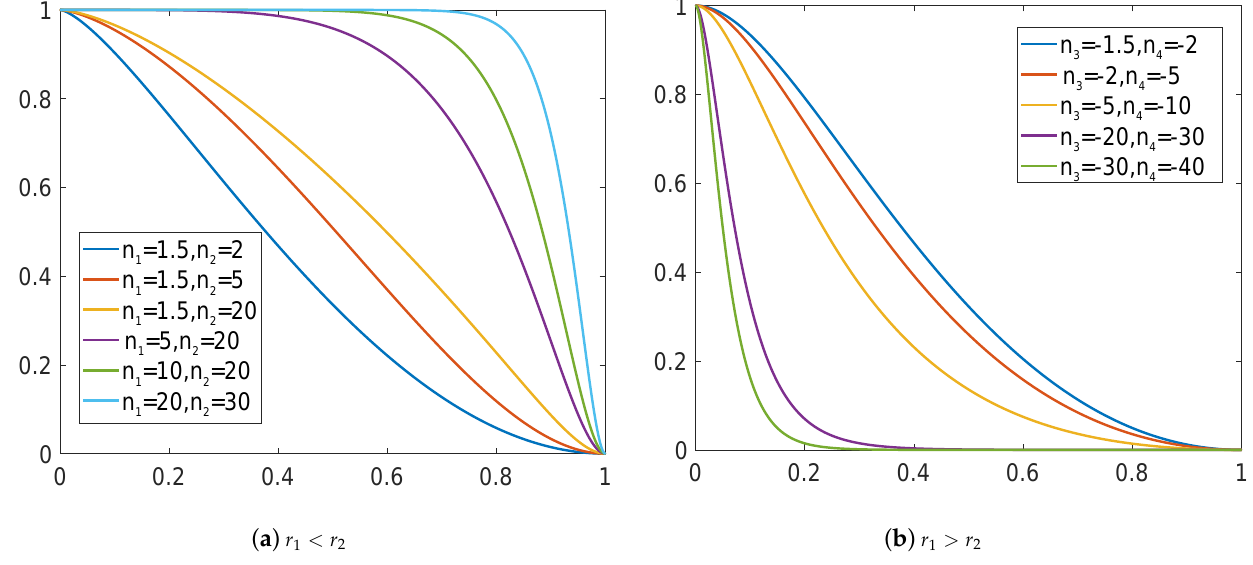
Figure 3. Effect of the shaping parameters on φ